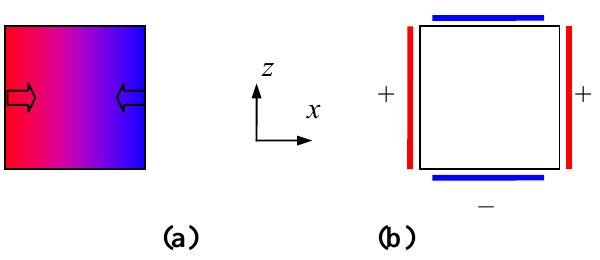
Figure 3. Schematic diagram of the drive beam’s cross section. (a) Strain distribution and electric field direction. (b) Electrode configuration corresponding to the electric field.